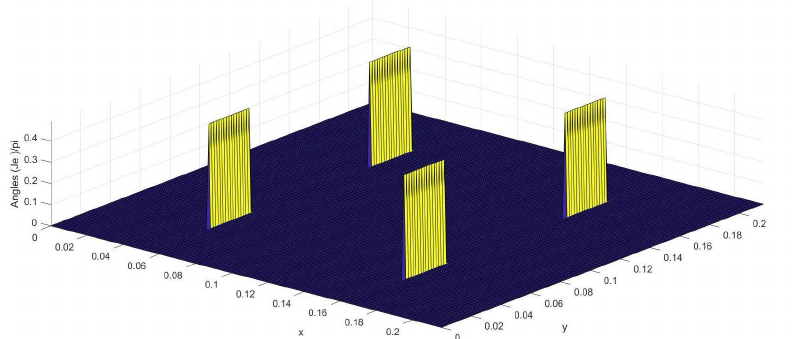
Figure 7. Current J e ’s phase (or Angle) of a symmetry configuration with an electric wall along (ox) and a magnetic wall along (oy): the amplitudes of the excitations are 1111 (MoM-GEC